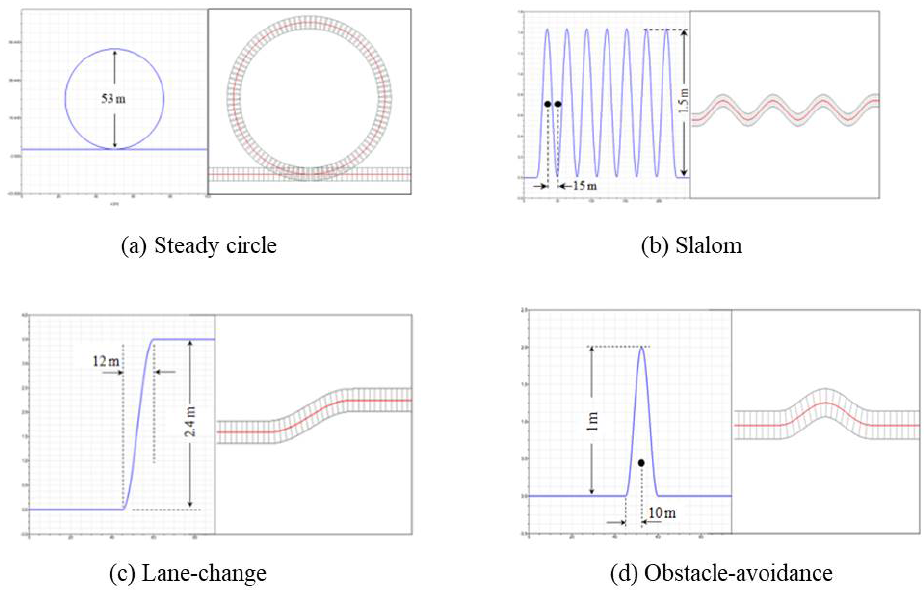
Figure 17. Routes for simulation.